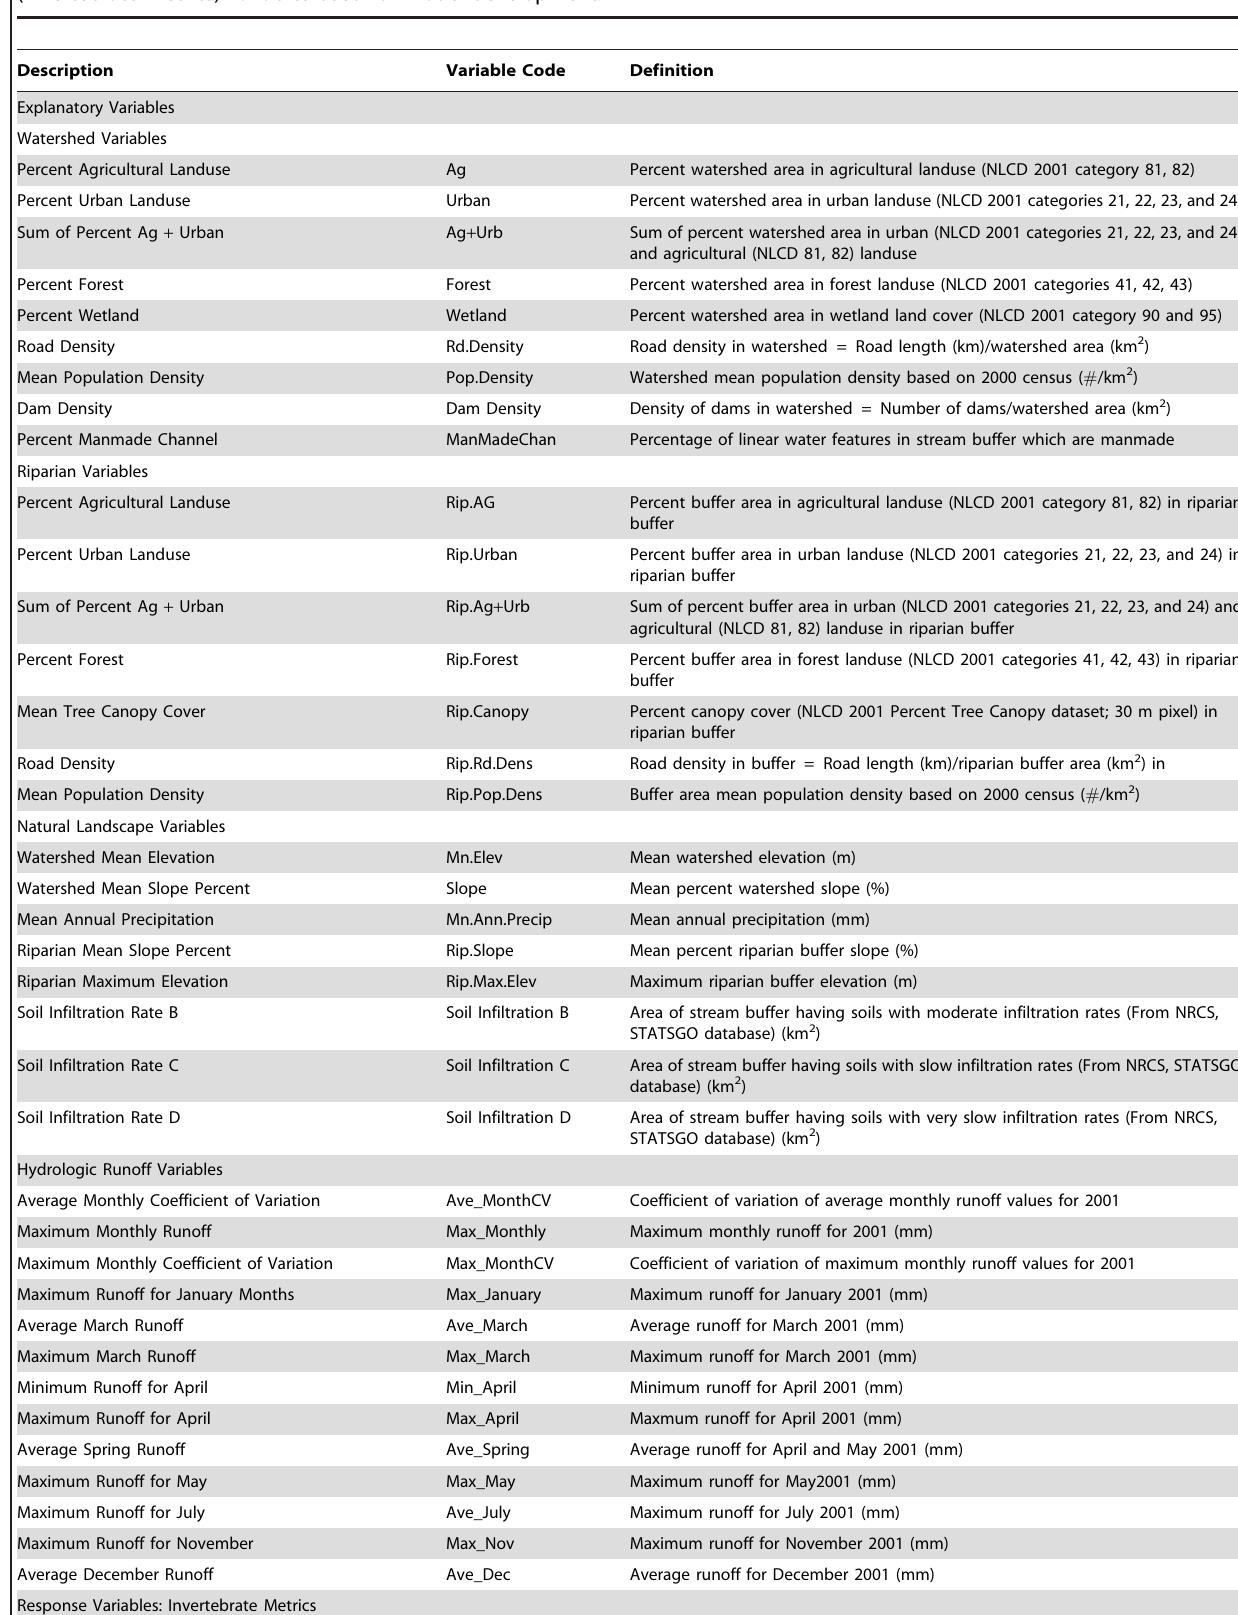
Table 1. Description, variable code and definition of explanatory environmental (landscape, riparian and habitat) and response (invertebrate metrics) variables used for model